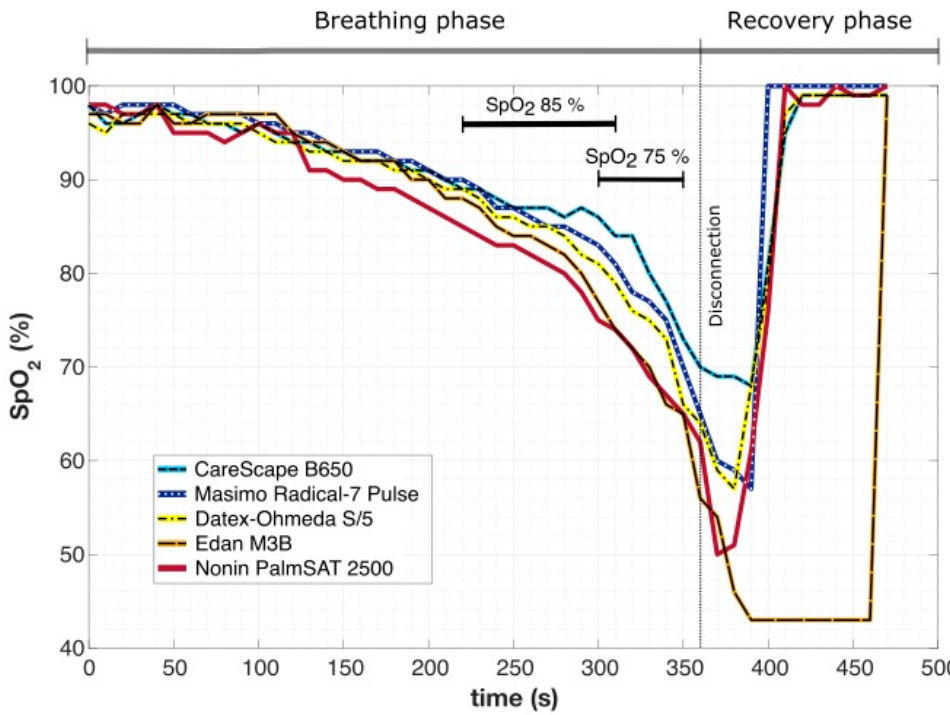
Figure 3. An example of SpO 2 waveforms simultaneously presented by five different pulse oximeters. The time difference between the point when the first and the last pulse oximeter showed the typical study endpoints SpO 2 85% and 75% is depicted as the black horizontal line. The pulse oximeter Edan M3B showed a stereotypical value of 43% for 70 s after the end of the breathing phase even though other devices presented values within the physiological range already.